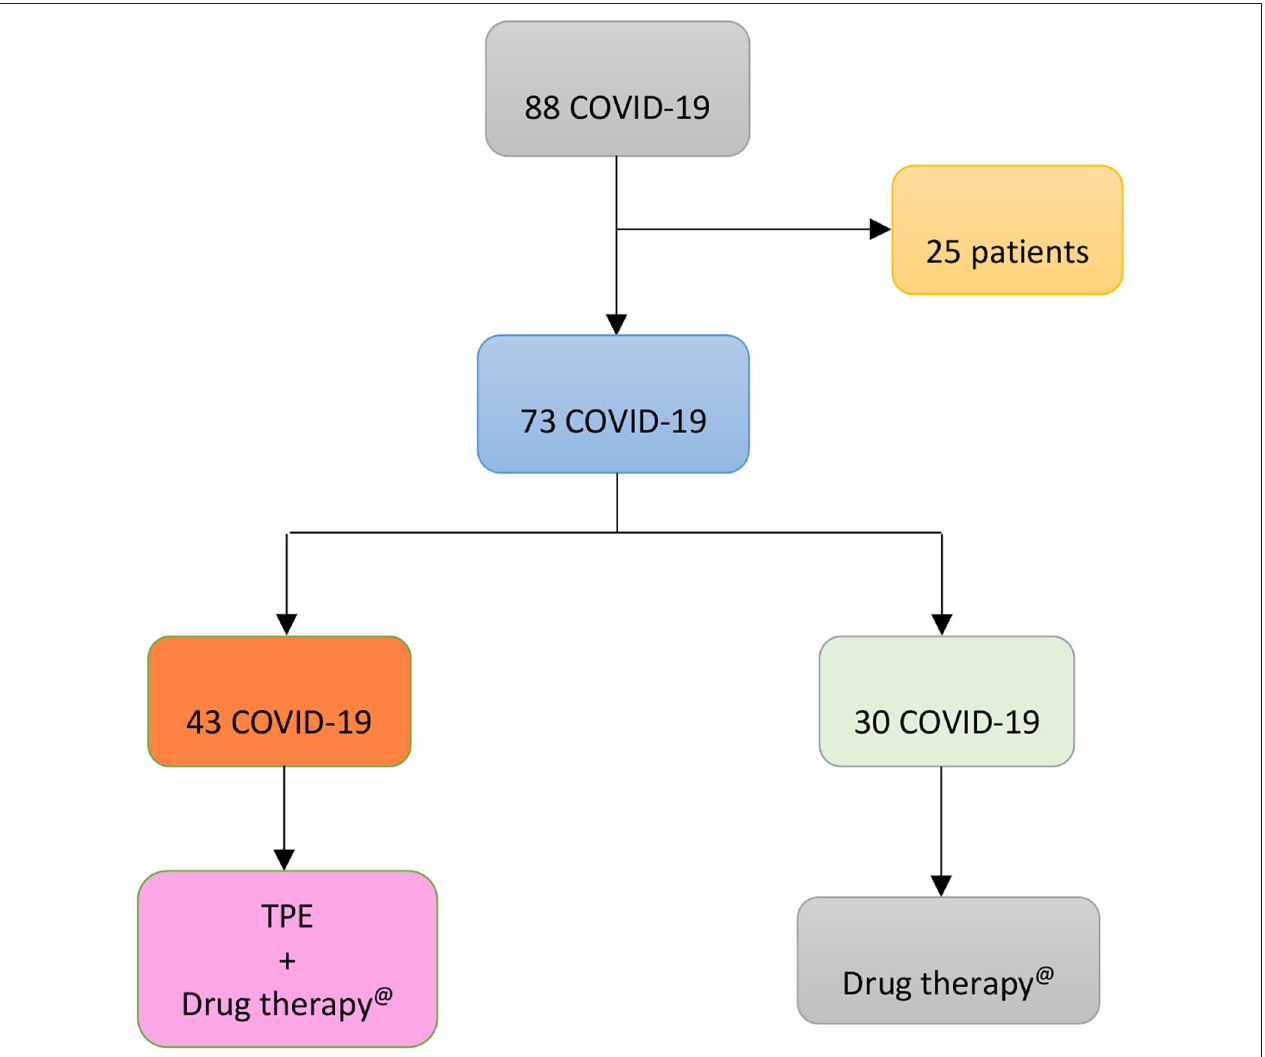
FIGURE 1 | Flow chart displaying the apportionment of 88 COVID-19 patients admitted to Baqiyatallah Hospital in Tehran (Iran) between 24 March and 20 May 2020. 25 patients were excluded because of multi-organ failure and 73 patients included in the study. The latter were broken down, according to clinical decision of doctors and patients’ will, in two groups: 30 patients (Group 1) untreated and 43 patients (Group 2) treated with